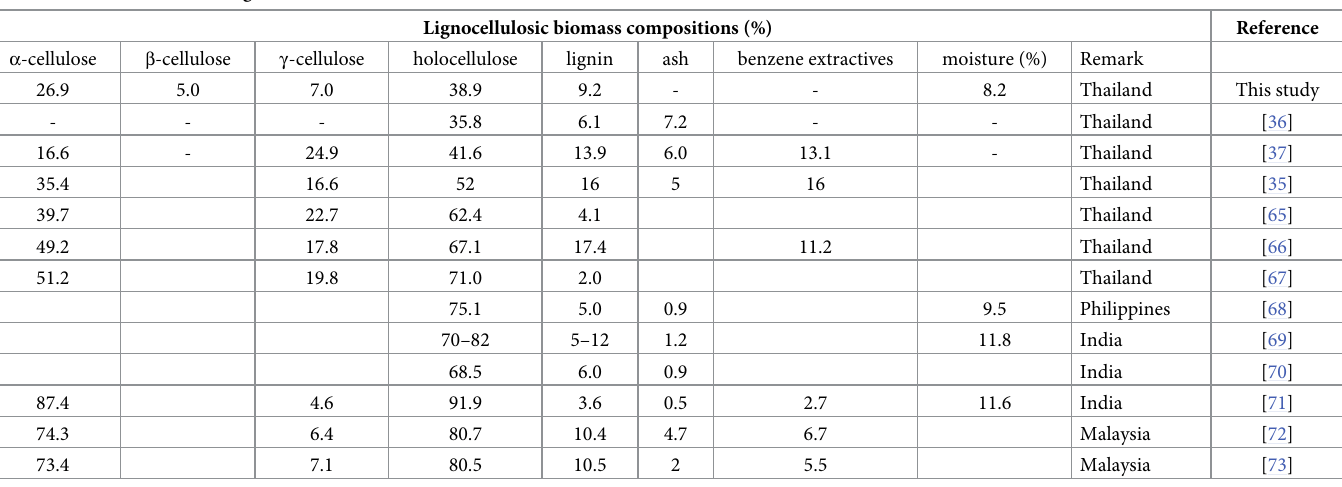
Table 1. Characterization of agro-industrial residues.